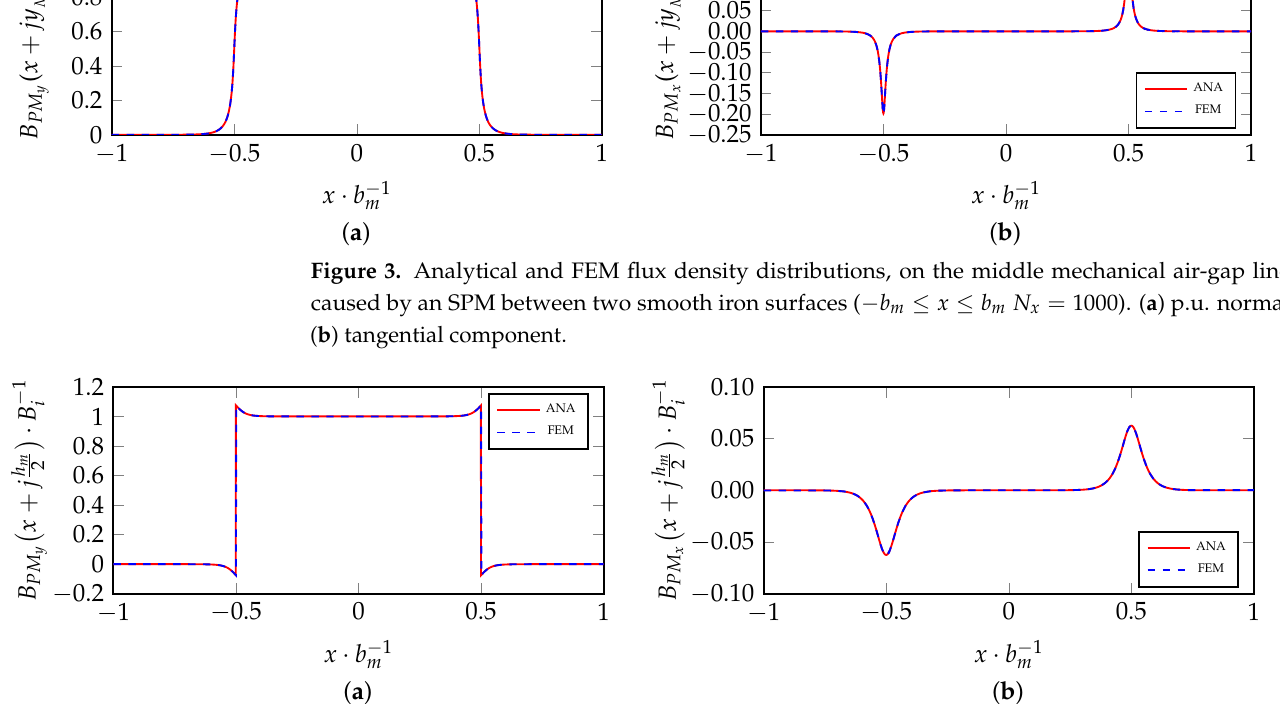
b m x b m N x = 1000). ( a ) p.u. normal; ( b ) tangential − ≤ ≤